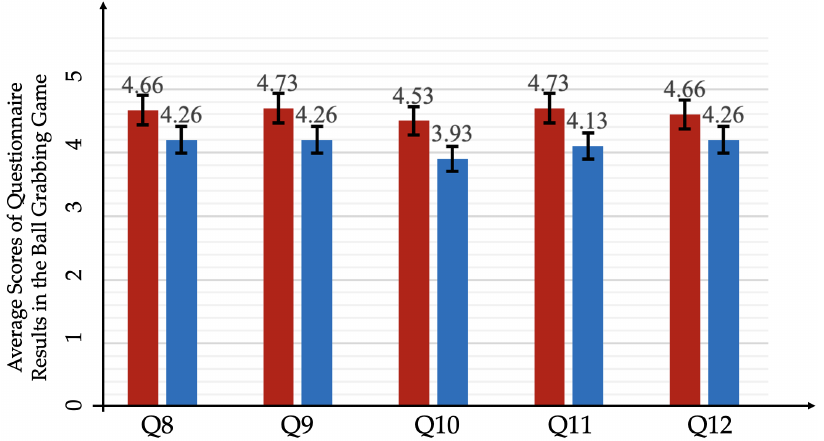
Figure 11. Questionnaire results in the archery game. Our proposed method and IK. Figure 13. Questionnaire results in the ball-grabbing game. Our proposed method and IK.